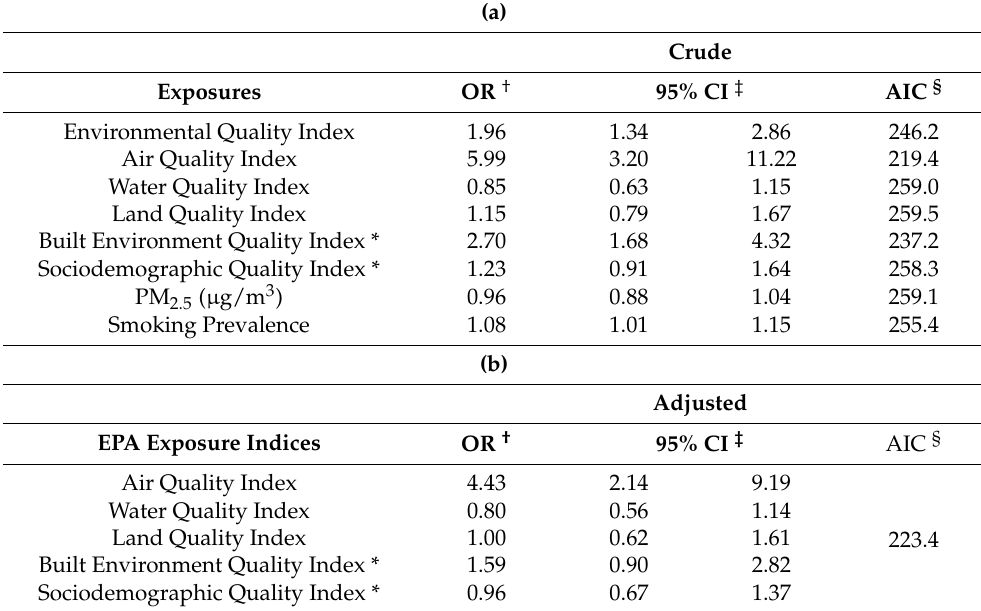
Table 3. ( a ) Association between environmental exposures and low-benefit county status for 257 SEER metropolitan counties, 2016—results of bivariate logistic regression models. ( b ) Association between environmental exposures and low-benefit county status for 257 SEER metropolitan counties, 2016—conditional results from a multivariate logistic regression